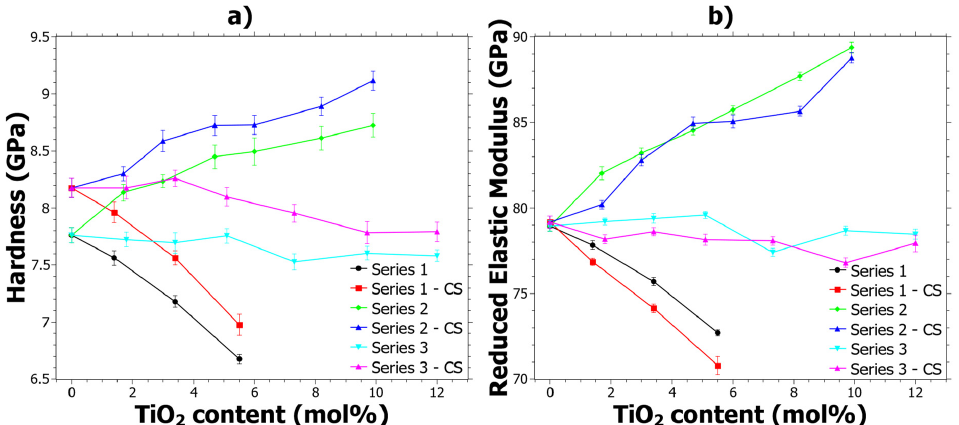
Figure 1. Properties determined by 75 mN nano-indentation before and after ion exchange: ( a ) Hard- ness and ( b ) Reduced Elastic Modulus ( E r ). The error bars are given from the standard deviations of the measurements. Series 1 refers to samples 1.1 to 1.4, Series 2 to samples 2.2 to 2.7, Series 3 to 3.2 to 3.7 and CS refers to values after ion-exchange strengthening.